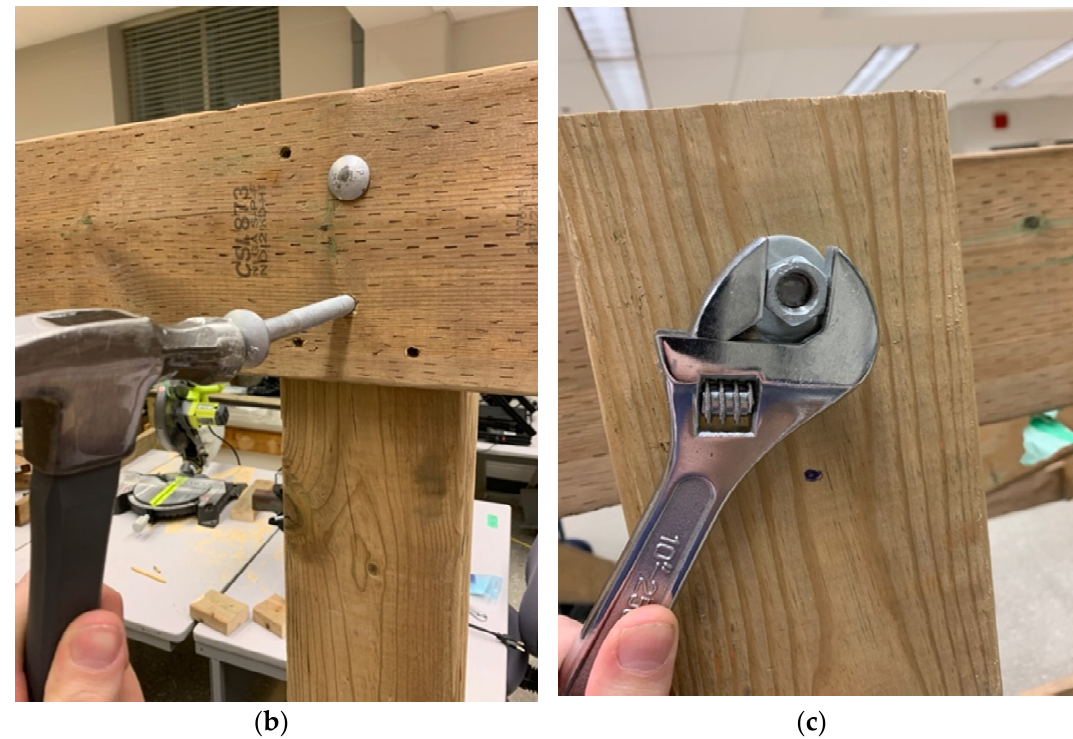
Figure 4. ( a ) 2 × 8 horizontal beam installment onto 4 × 4 and 6 × 6 posts, ( b ) ½” holes are drilled, and carriage bolts are inserted, and ( c ) connections are tightly secured using a nut and washer.